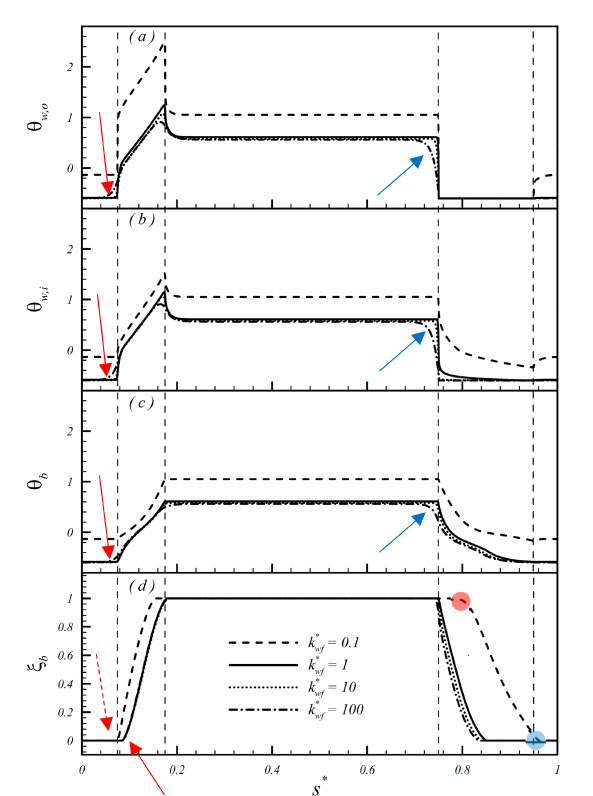
Figure 4. Axial distributions of temperatures (( a ) θ w , o , ( b ) θ w , i , ( c ) θ b ) and ( d ) ξ b for di ff erent k ∗ = 0.4, l = 0.75, Sb ∗ = 0.6, Ste ∗ = 0.1, Ra ∗ = 10 10 , c ( AR = 1, l ∗ z h